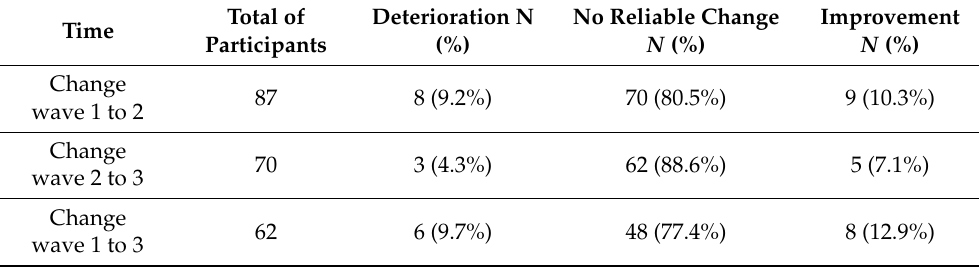
Table 1. Evolution of participants in the mental health indicator considering longitudinal monitoring Reliable Change Index.